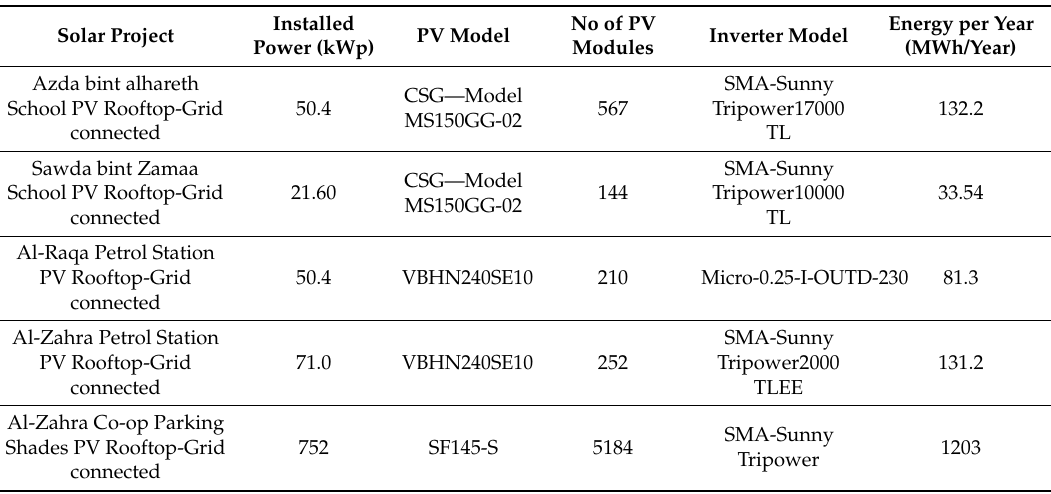
Table 3. Ongoing solar projects in Kuwait. Adapted from